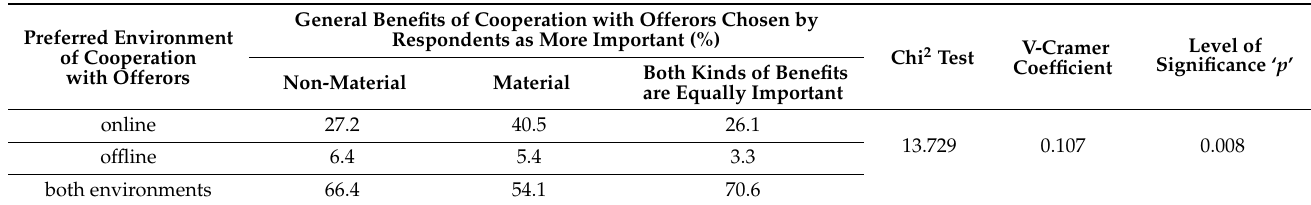
Table 3. Respondents’ preferred environment of cooperation with offerors and the general benefits of cooperation with offerors chosen by respondents as more